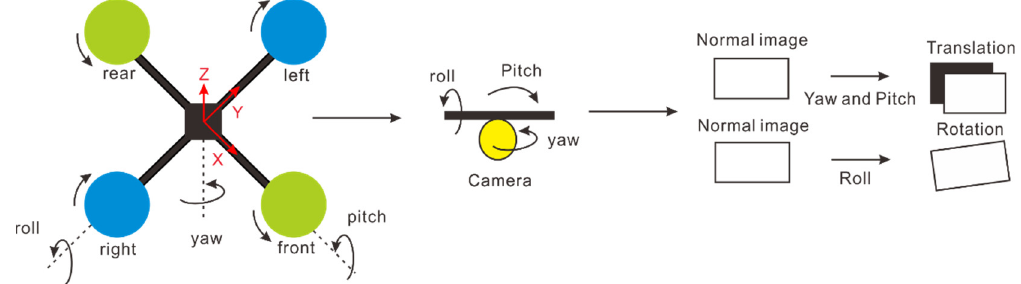
Figure 1. Unmanned aerial vehicles (UAV) movement modeling.